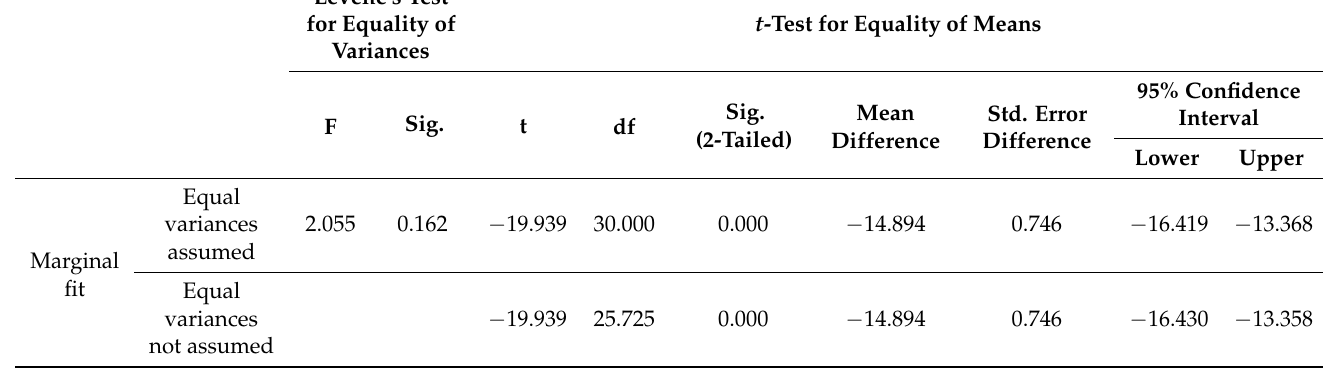
Table 2. Independent samples t